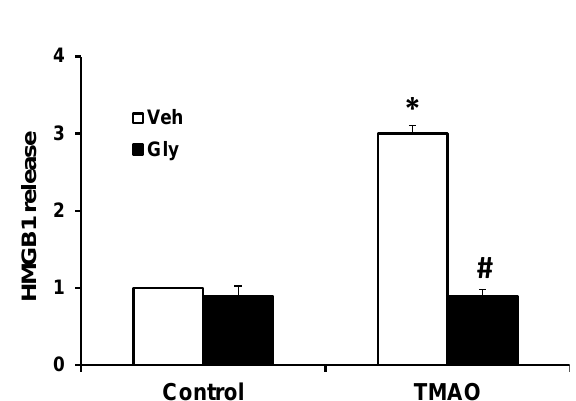
Figure 2. E ff ect of TMAO on the expression of HMGB1 in EOMAs. ( A ) RT-PCR analysis of high-mobility group box 1 (HMGB1) expression in EOMAs treated with di ff erent concentration of TMAO ( n = 6). ( B ) Summarized ELISA data showing the HMGB1 extracellular release with or without stimulation of TMAO and / or glycyrrhizin (120 µ m). Veh: vehicle, Gly: glycyrrhizin. * Significant di ff erence from control, # significant di ff erence from